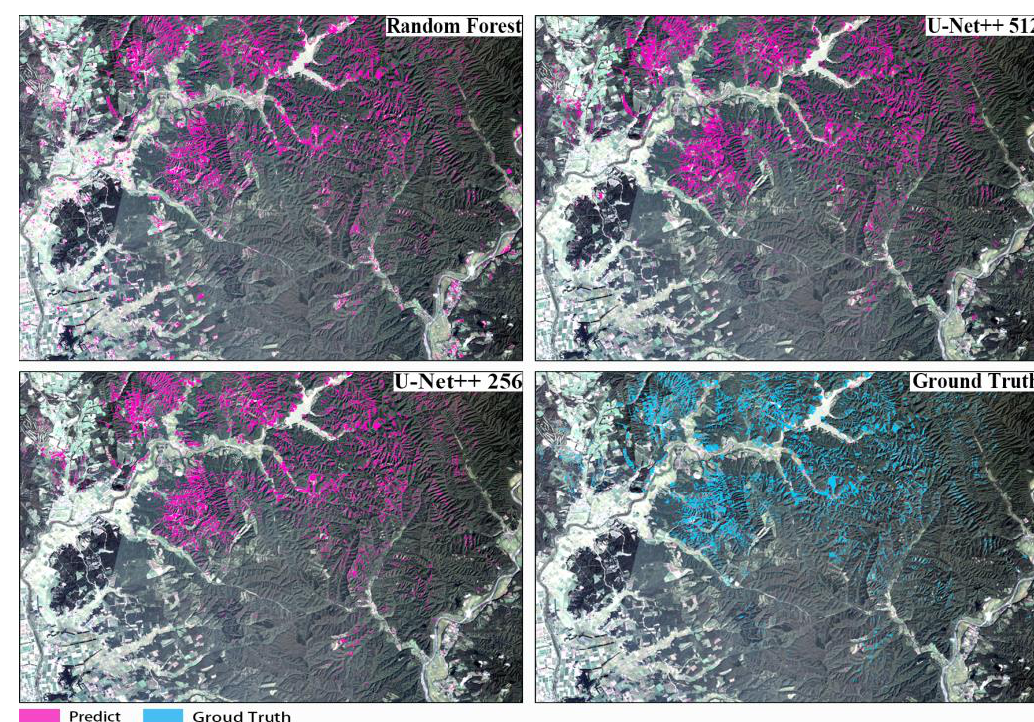
Remote Sens. 2022 , 14 , x FOR PEER REVIEW Figure 9. Prediction results of the three models. Figure 9. Prediction results of the three models.